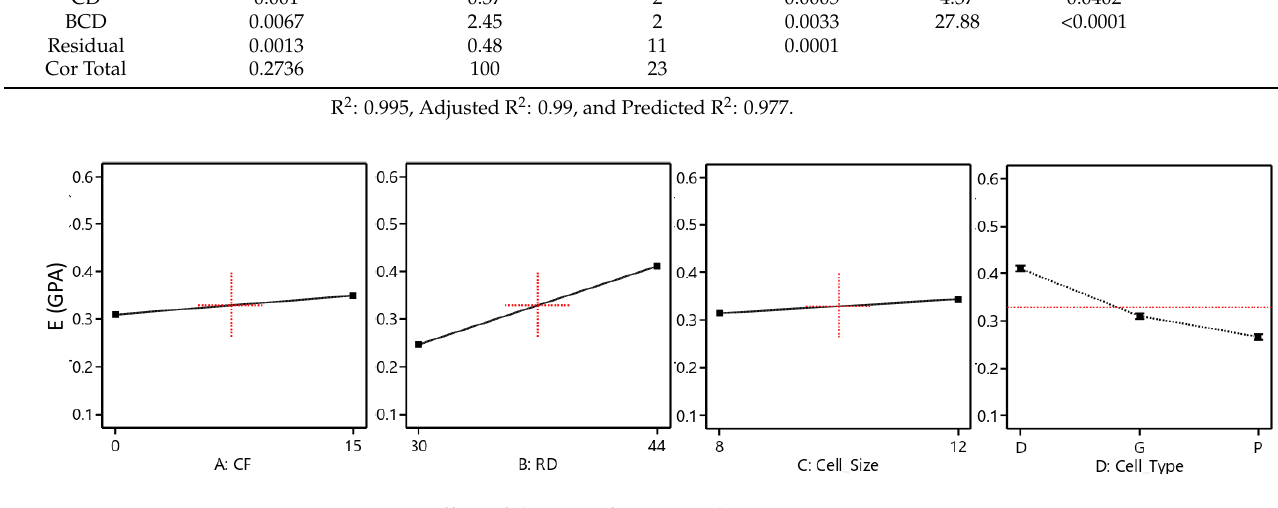
Figure 9. Effect of the main factors on the E.